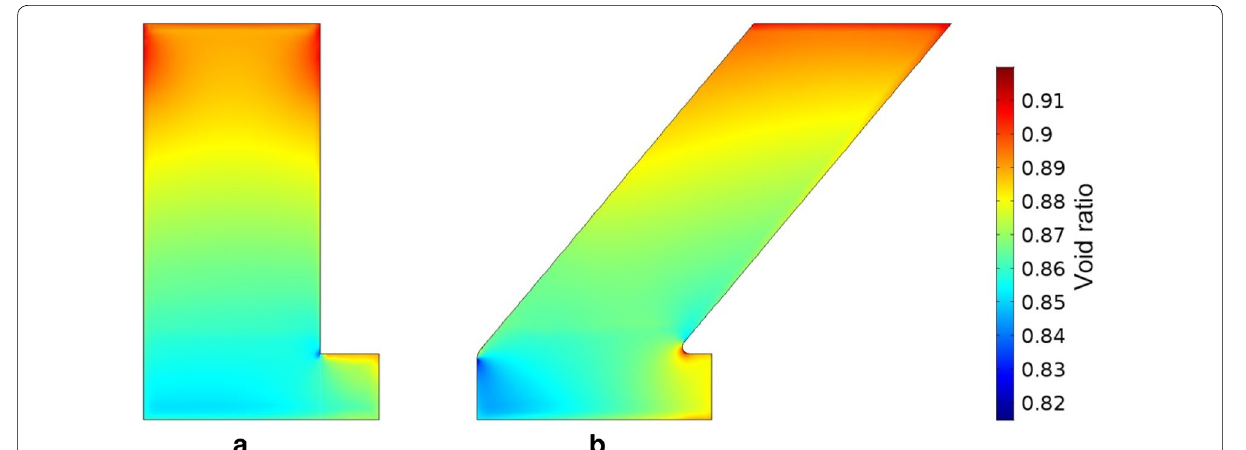
Fig. 16 Spatial distribution of void ratio of CPB with different inclination angles after 7 days of curing: a 90°; b 50°